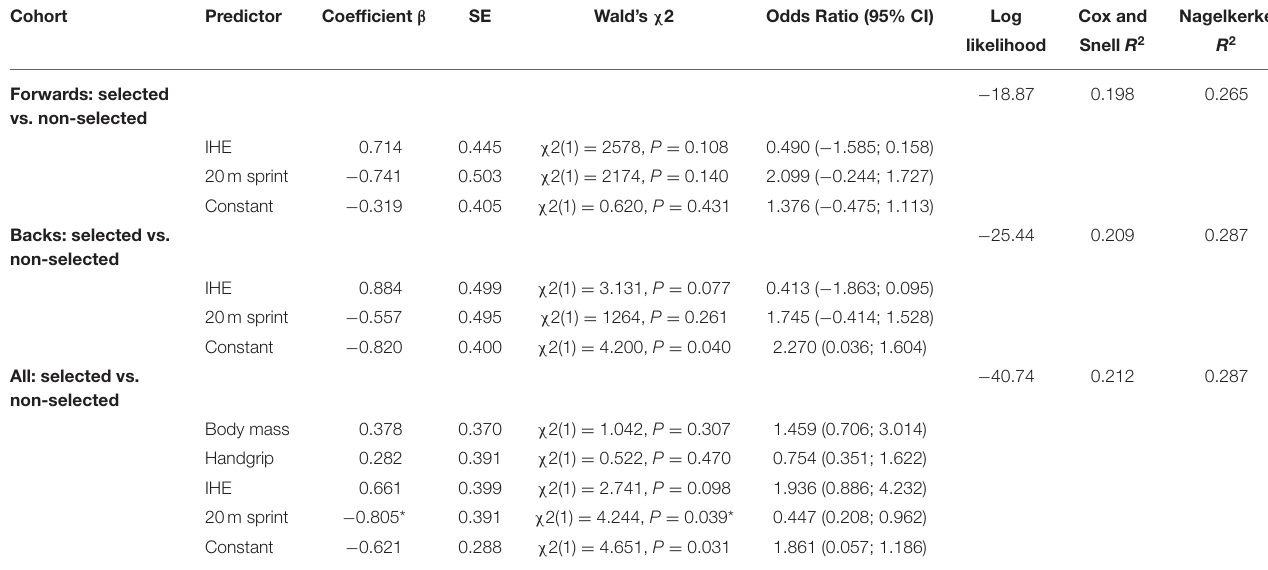
TABLE 5 | Main variables for multivariate logistic regression for selection and positions. Cohort Predictor Coefficient β SE Wald’s χ 2 Odds Ratio (95% CI) Log Cox and Nagelkerke